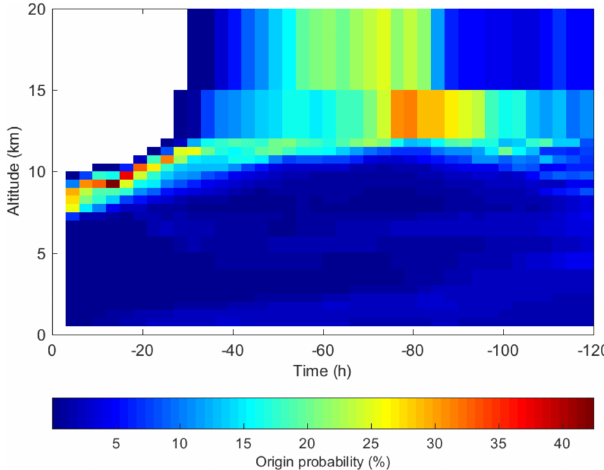
Figure 14. As in Fig. 8, except for the domain 24–25 ◦ N, 121.5– 122.5 ◦ E (6.5–8.5km altitude), on 16 September at